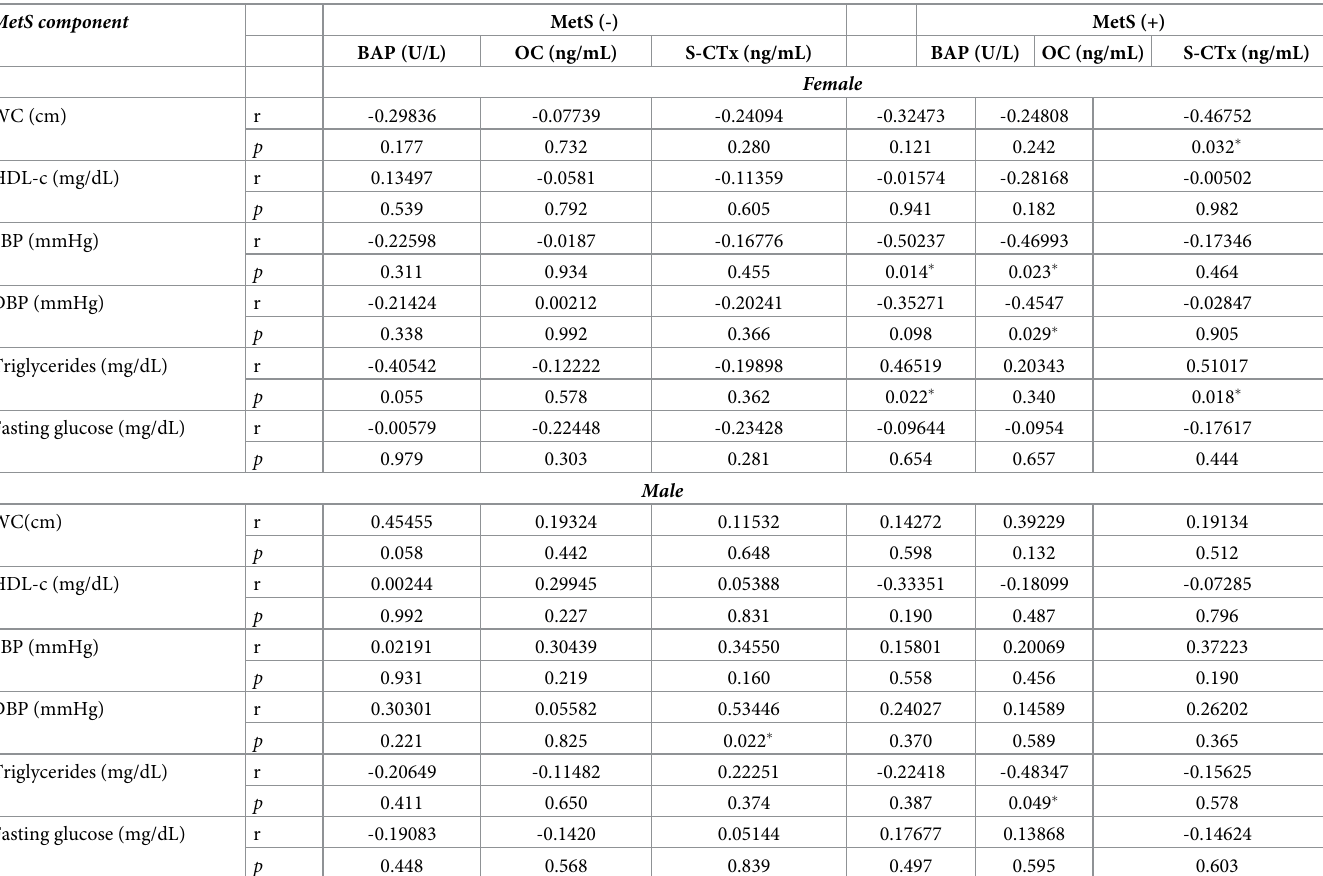
Table 5. Pearson’s correlation between bone biomarkers and metabolic syndrome components in adolescents of both sexes with and without MetS. MetS component